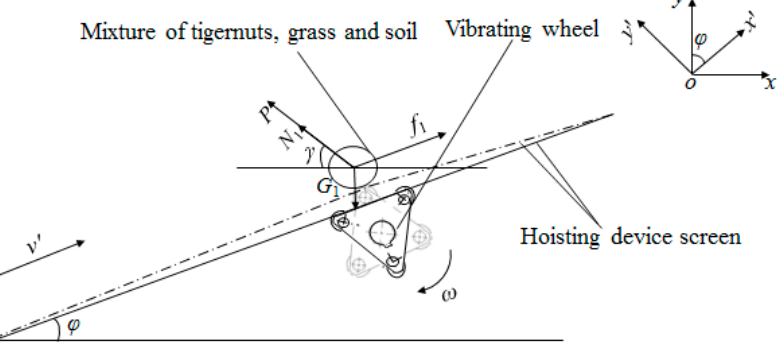
Figure 6. Force analysis of mixture of tiger nut, soil and grass blend on hoisting sieve.